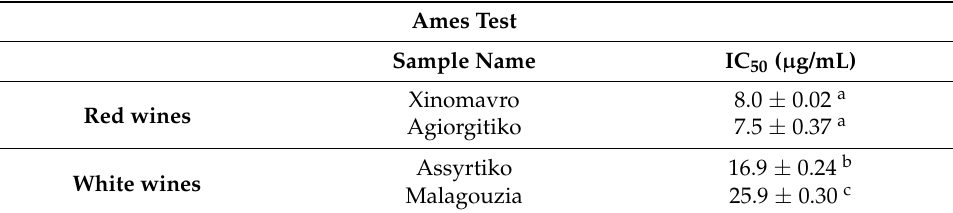
Table 4. Antimutagenic capacity of the tested wine extracts using Ames